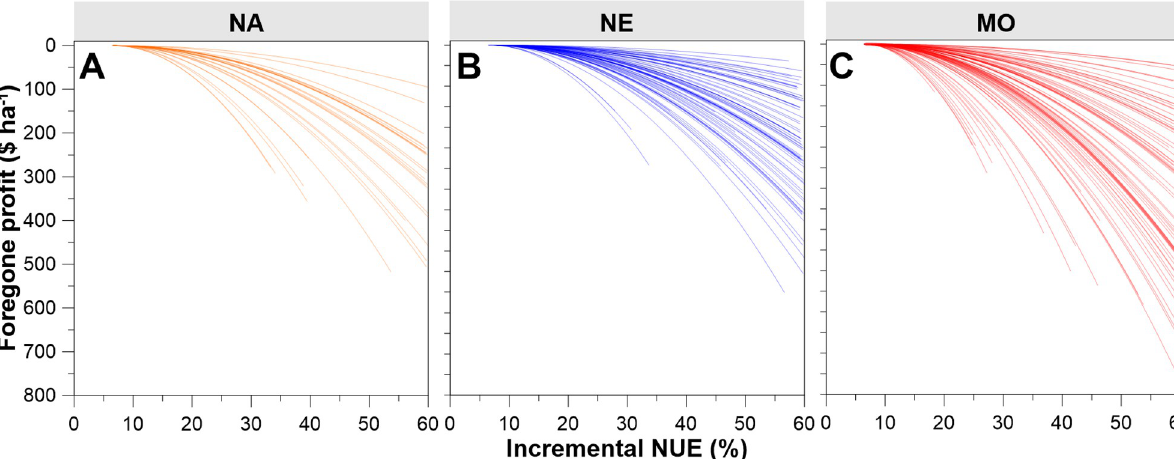
Fig 4. Foregone profit (relative to EONR) is minimal when iNUE is low. (A-C) Foregone profit for each of the three datasets, calculated as the profit difference at iNUE and economically optimal nitrogen rate (EONR). iNUE was limited to < 60%. Each line represents one